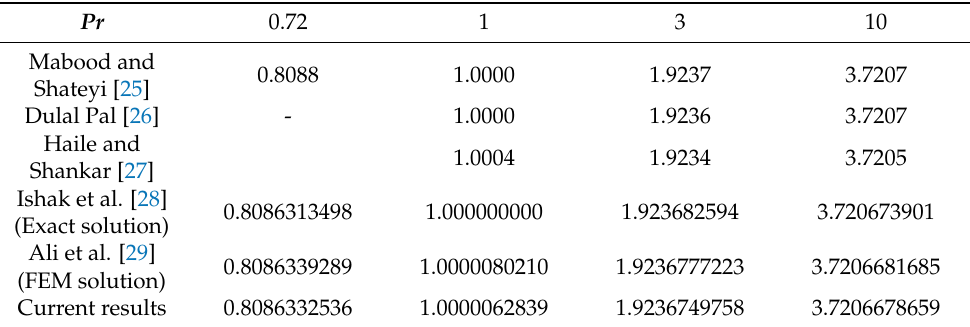
Table 2. A comparison of the − θ (cid:48) ( 0 ) with published results for different values of Pr